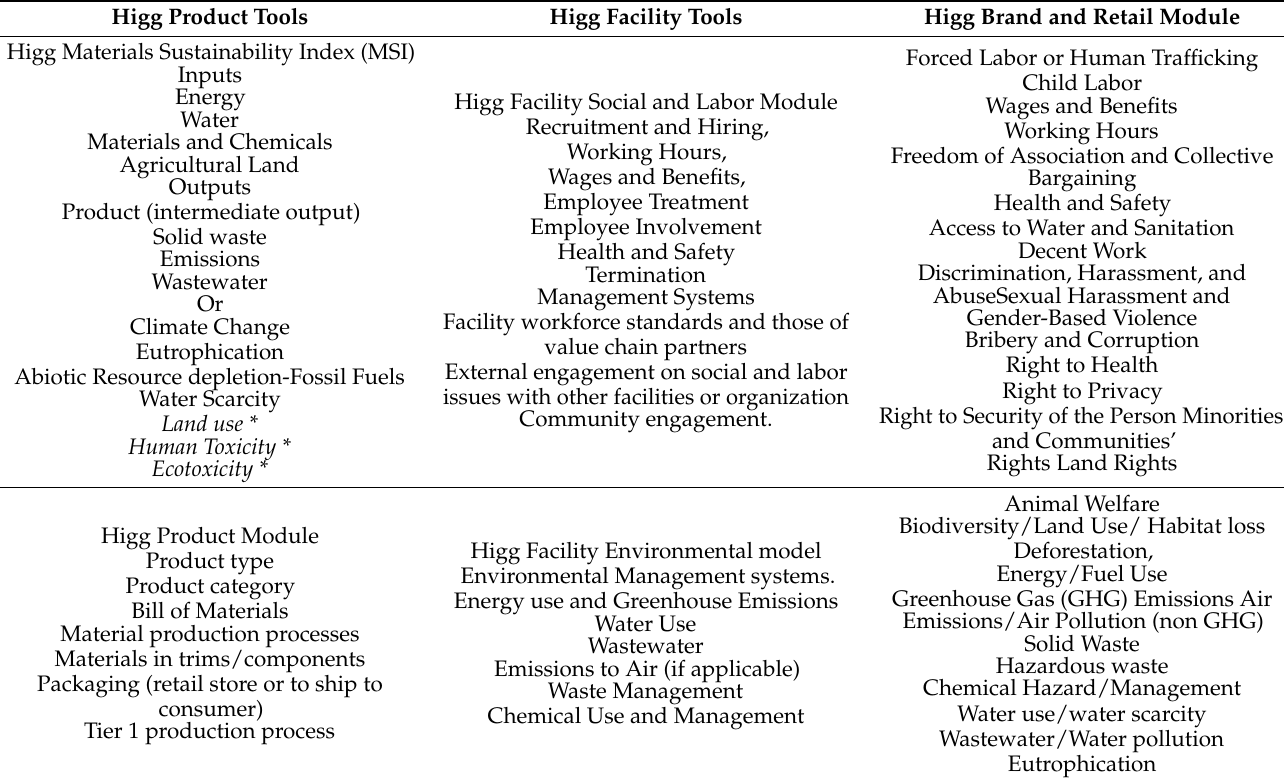
Table 4. Higg Index—summary table (* not included on the MSI score, at the moment) [61]. Higg Product Tools Higg Facility